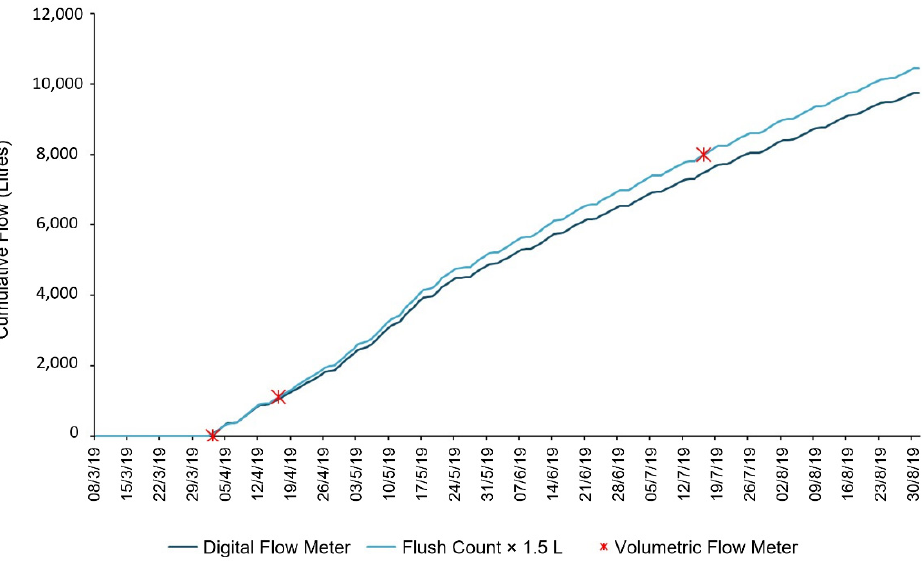
Figure 4. Comparison of flush counts, flow meters and water meter at HB-02-289-M-2.